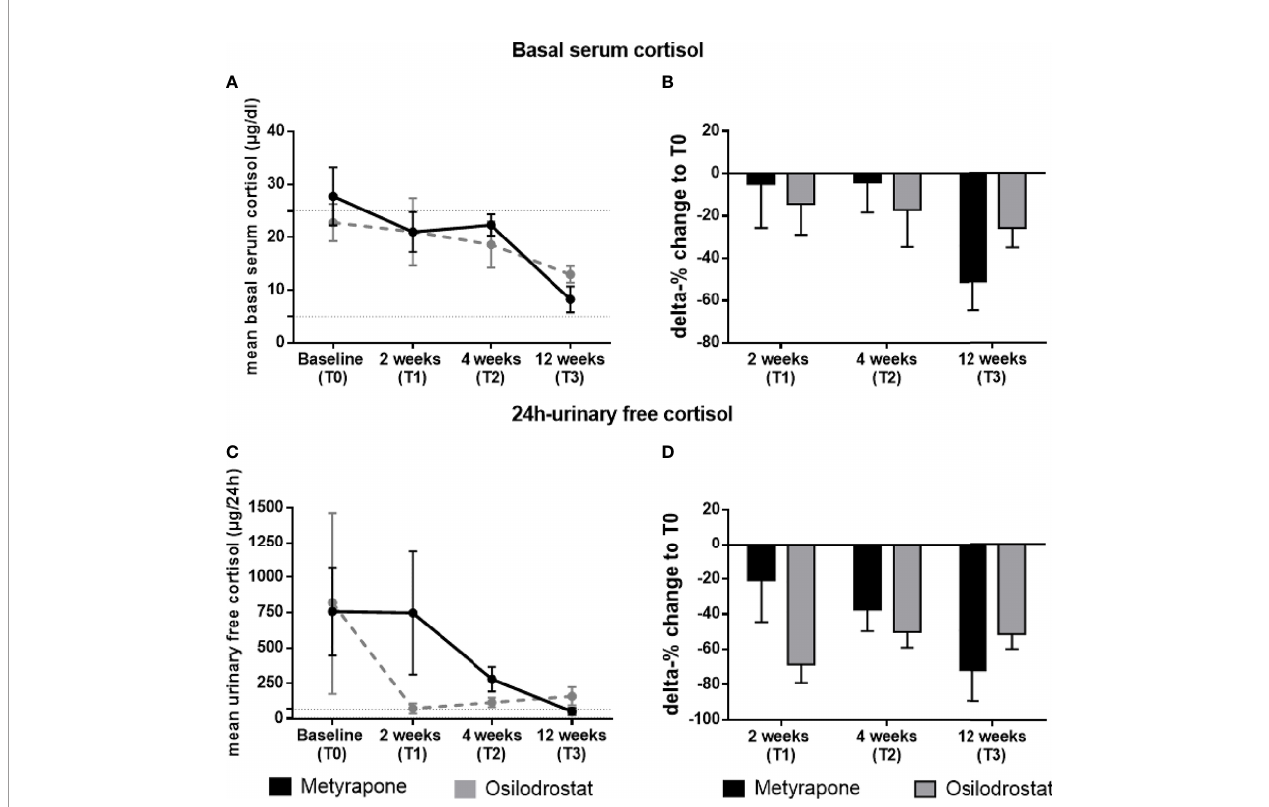
FIGURE 2 | Changes of basal serum cortisol and 24h-urinary free cortisol during the follow-up in patients treated with metyrapone or osilodrostat. Changes in absolute values (A) and delta percentage (B) of morning basal serum cortisol during metyrapone or osilodrostad treatment from T0 (baseline) to 2 weeks (T1), 4 weeks (T2) and 12 weeks (T3) of therapy. Changes in absolute values (C) and delta percentage (D) of 24h-urinary free cortisol during metyrapone or osilodrostad treatment from T0 (baseline) to 2 weeks (T1), 4 weeks (T2) and 12 weeks (T3) of therapy. Absolute values are reported with mean and standard error of mean (SEM). Normal range of serum cortisol and 24h-urinary free cortisol is reported within the dotted lines in (A, B)